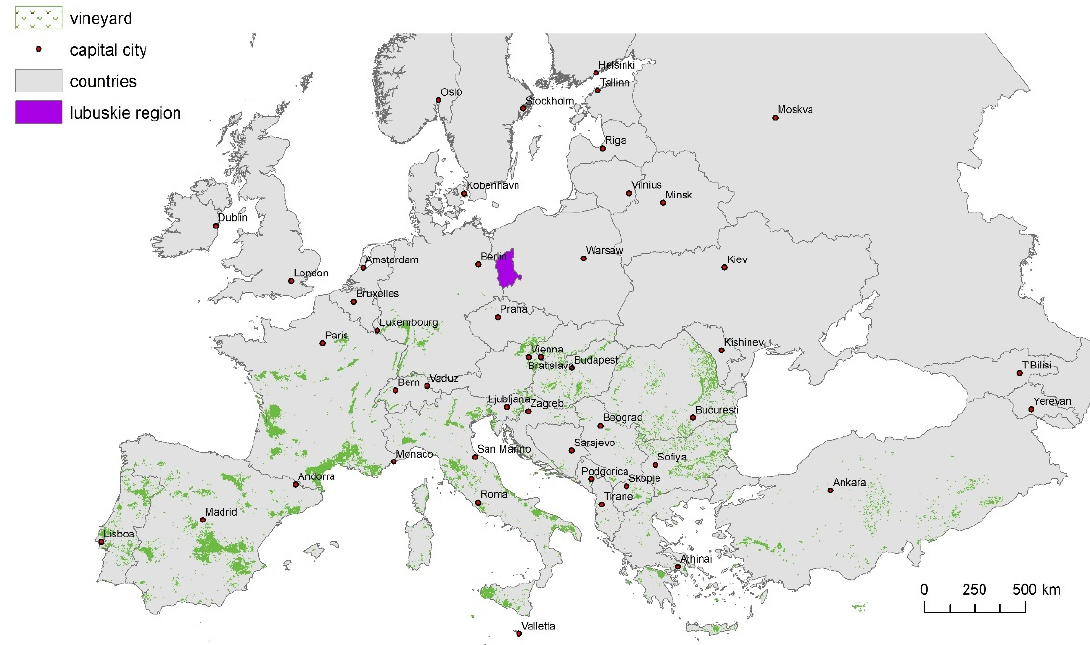
Figure 1. Location of the Lubuskie Region against other European vineyards in 2018. Source: own study based on Corine Land Cover data.